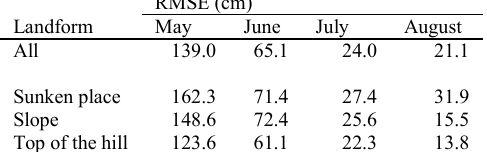
survey : Figure 8 shows comparison between volume of M. sinensis derived from UAV data and biomass derived from vegetation survey. The volume derived from UAV data was significantly correlated with biomass derived from vegetation survey with R 2 value of 0.63 (May, Figure 8a), 0.78 (June, Figure 8b), 0.76 (July, Figure 8c) and 0.55 (August, Figure 8d), respectively ( p < 0.01). Biomass of M. sinensis was best estimated using June data (Figure 8b).